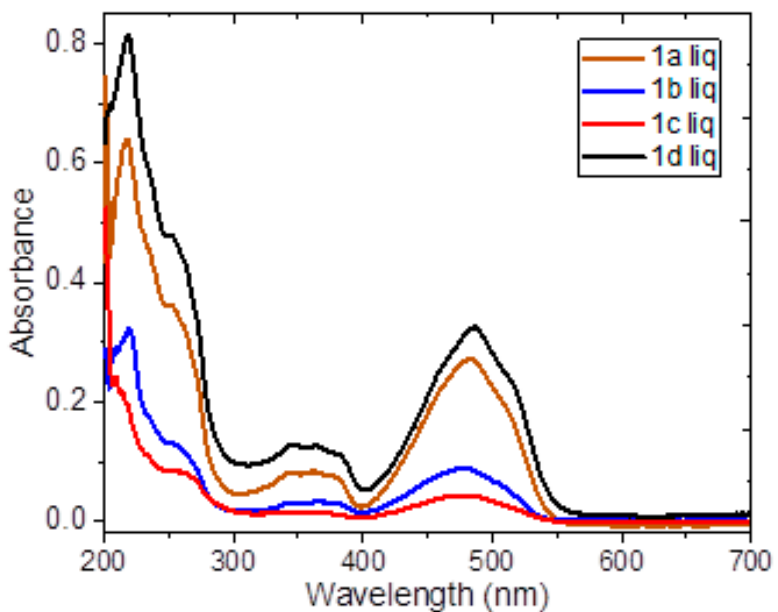
Figure 3. Electronic absorption spectra of 1a – 1d recorded in methanol at a concentration of 2.04530 × 10 − 5 M. Table 3. Thermal data (°C) of pentacoordinated organotin(IV) complexes 1a – 1d .